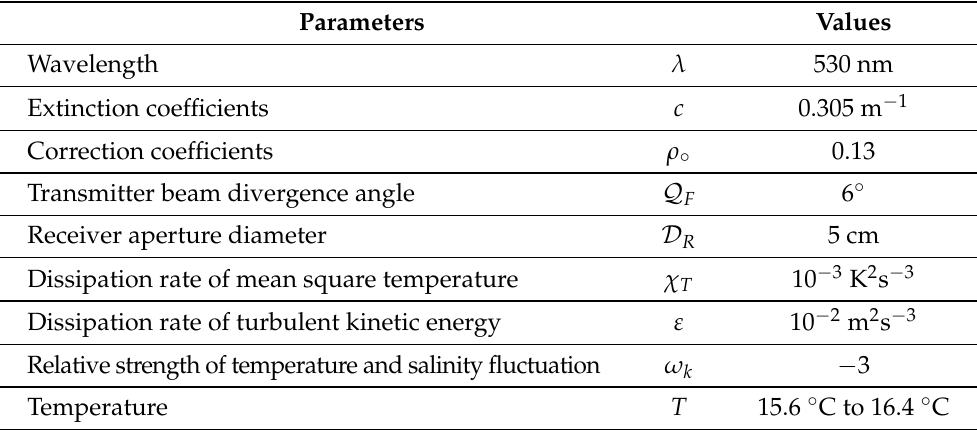
Table 1. Parameters of spatial power